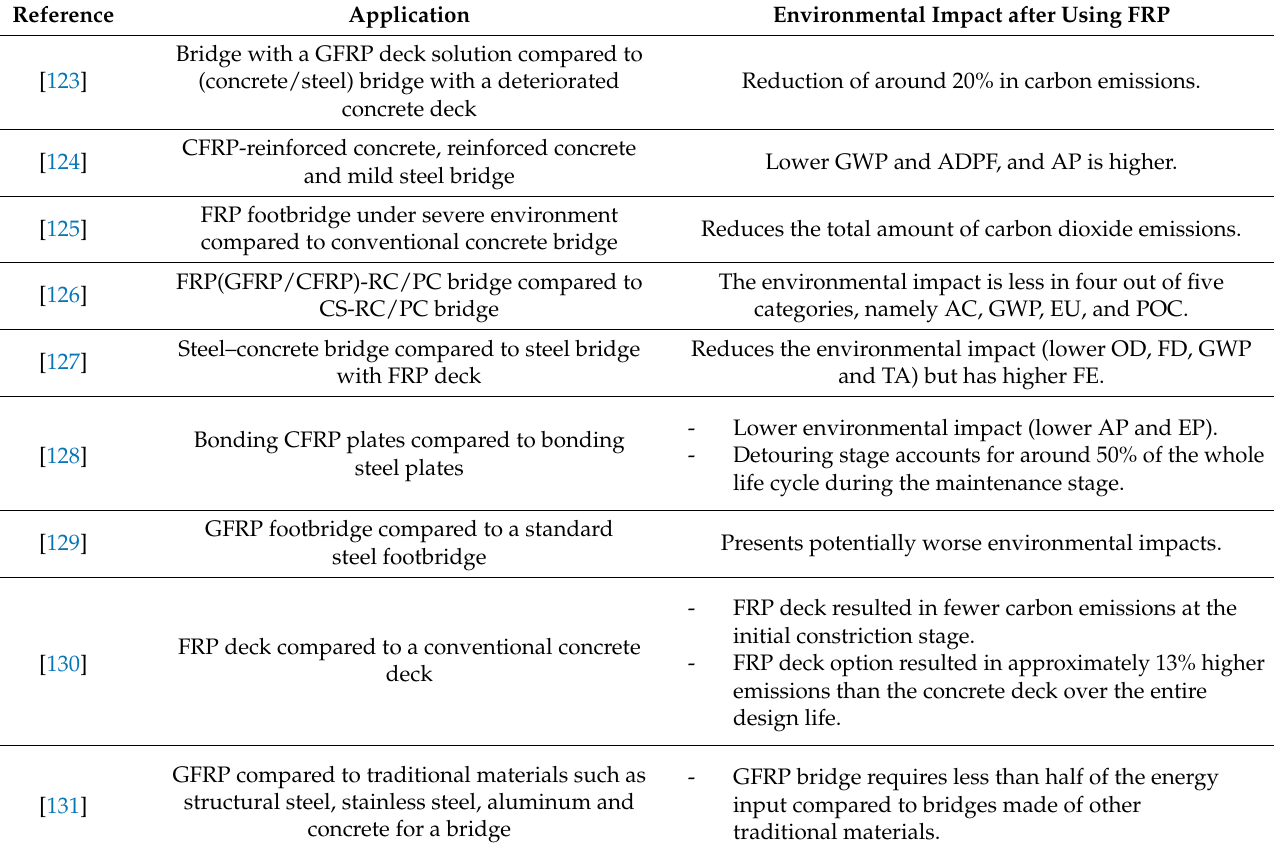
Table 9. Environmental impact of FRPs used in